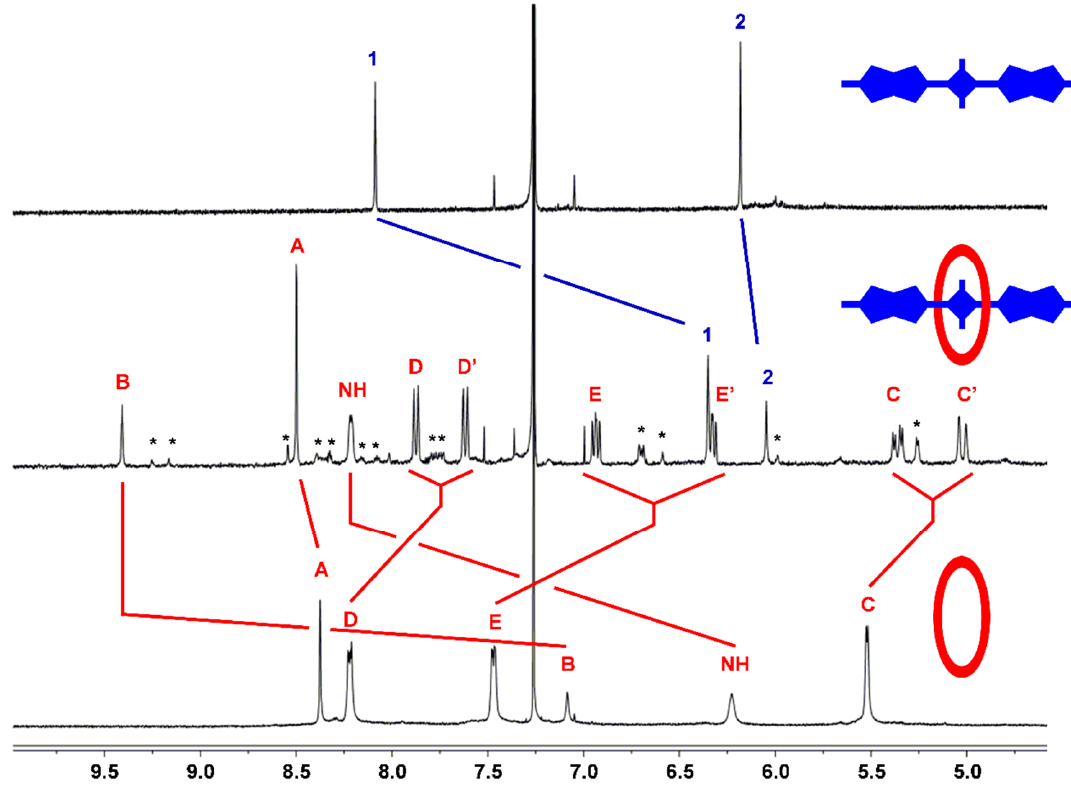
Figure 2. Comparison of partial 1 H-NMR spectra for separate samples of free S3 , M1 ⊃ S3 , and free M1 in CDCl 3 . Atom labels are provided in Scheme 2. Red and blue lines indicate major changes in chemical shifts upon complexation. * designates NMR signals for the minor M1 ⊃ S3 complex with encapsulated S3 in a cis conformation (trans/cis ratio for encapsulated S3 is >10:1). See Scheme 2 for atom labels which are numbers (for S3 ) and letters (for M1 ).